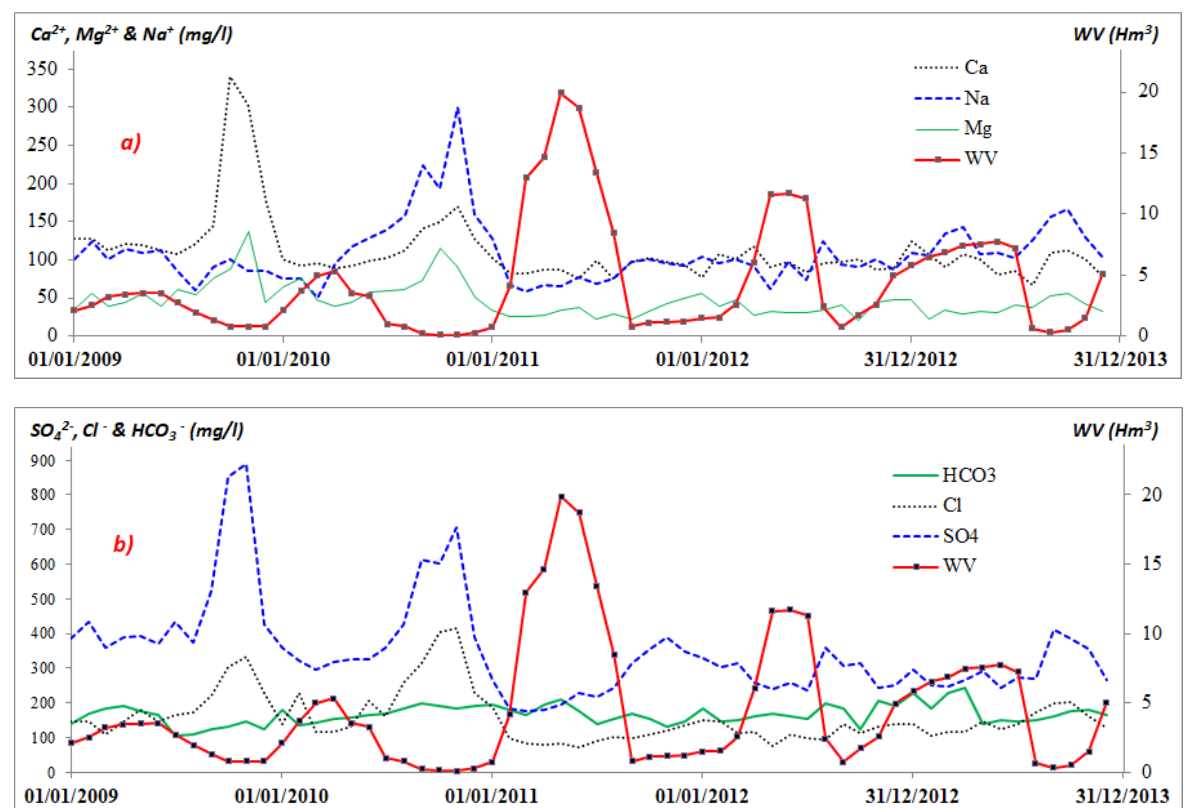
Fig. 2. Temporal variation of WV (Hm 3 ) versus, (a) cations and (b) anions in Oued Fodda